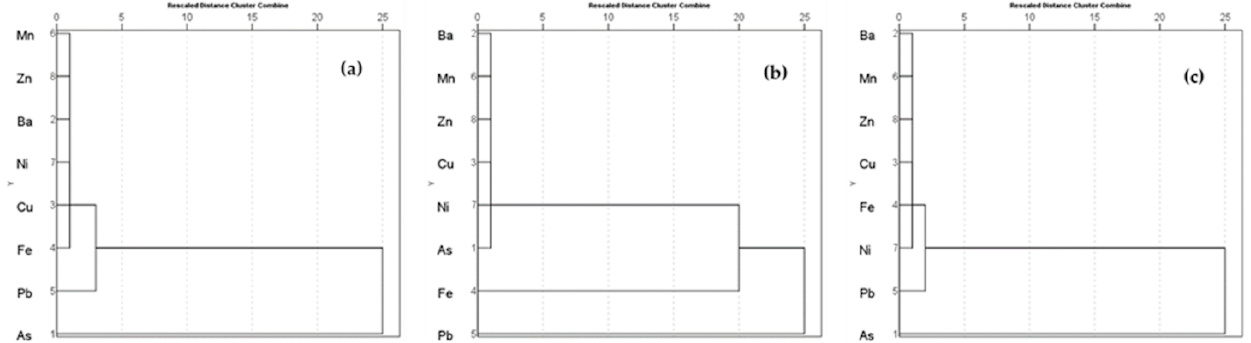
Figure 13. Cluster analysis dendrogram of HMMs in ( a ) WRS, ( b ) GW, and ( c ) TW.